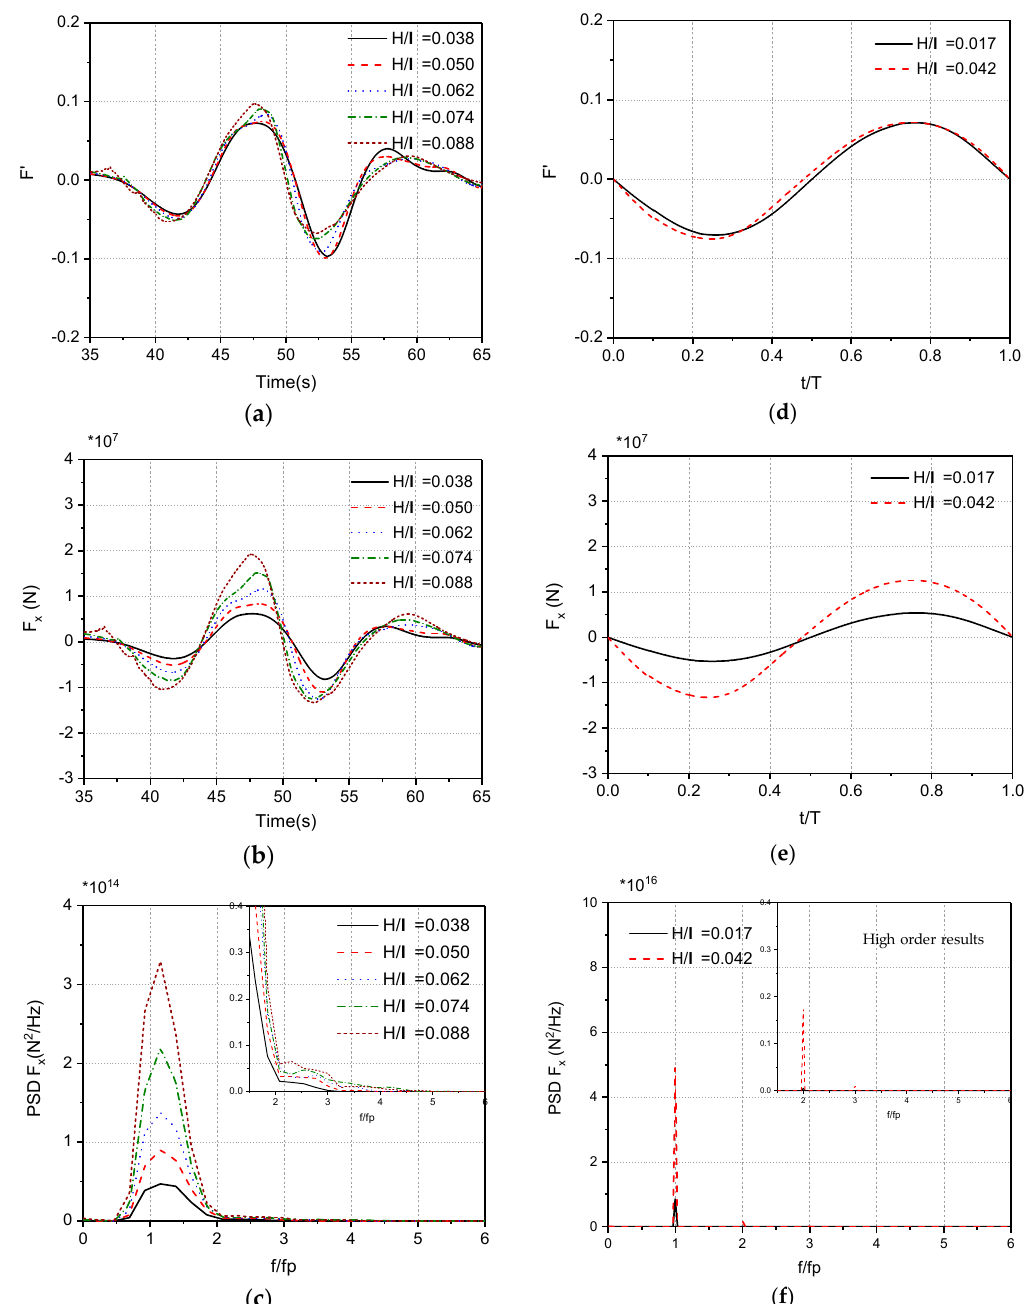
Figure 22. Inline force and PSDs of semi-submersible platform under different focused waves (Case 1 to Case 5) in floating semi-submersible platform simulations: ( a ) Dimensionless inline force F’ under focused wave (Cases 1 to Case 5) ( b ) Dimensional inline force Fx under focused wave (Case 1 to Case 5) ( c ) PSDs under focused wave (Cases 1 to Case 5) ( d ) Dimensionless inline force F’ under regular wave (Cases 6 and Case 10) ( e ) Dimensional inline force Fx under regular wave (Case 6 and Case 10) ( f ) PSDs under regular wave (Case 6 and Case 10).